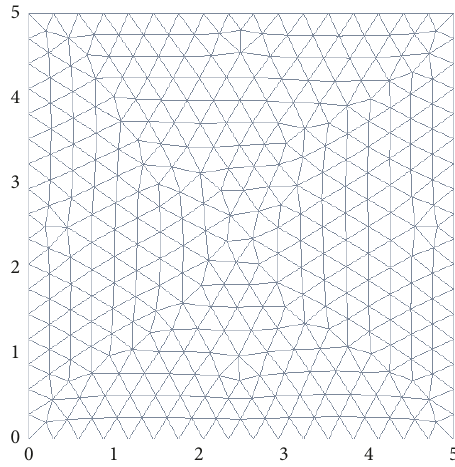
Figure 1: Model mesh for Case 1. Dimensions are 5m × 5